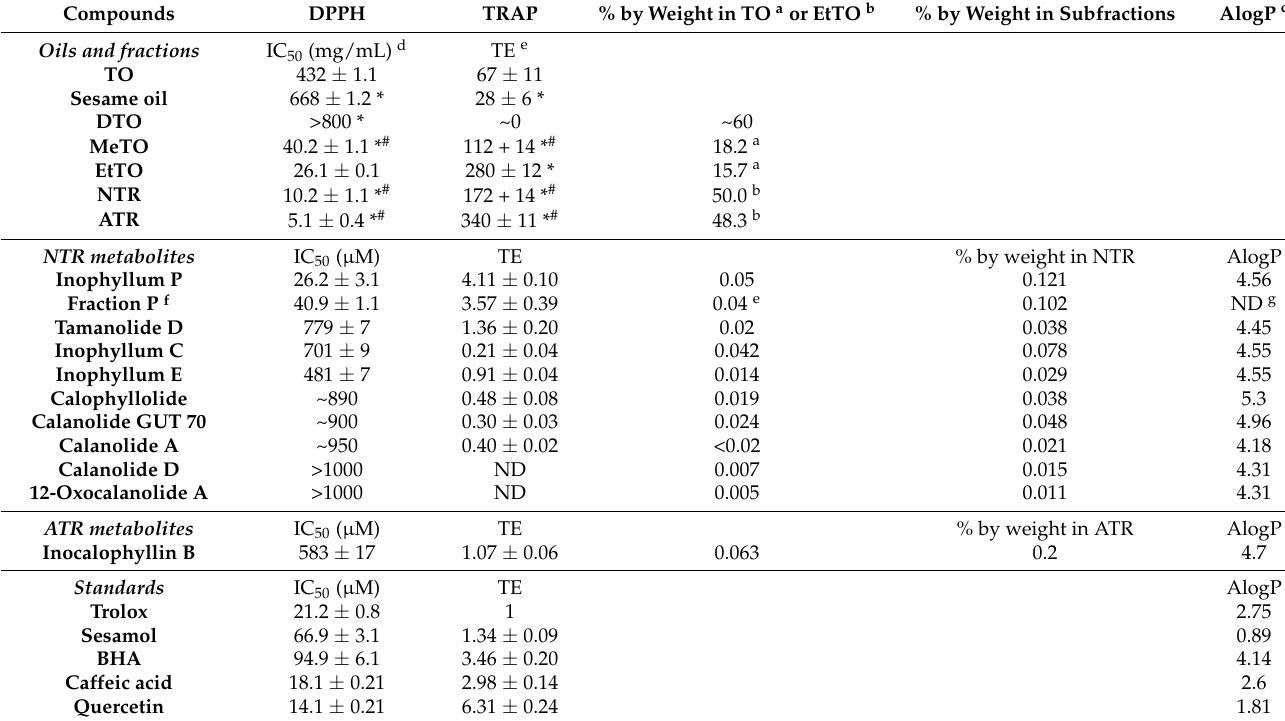
Table 2. Antioxidant capacities of Tamanu oil resin extracts, neutral (NTR) and acidic (ATR) subfractions and selected isolated metabolites by the DPPH and TRAP